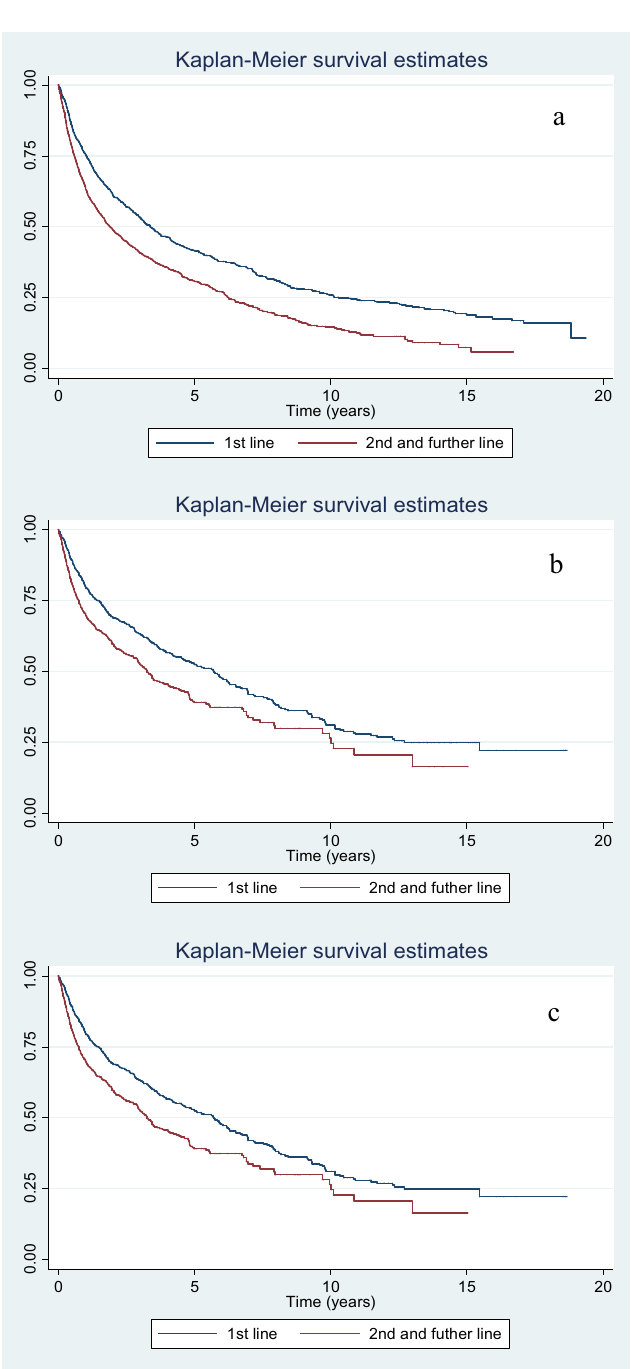
Figure 2. Kaplan–Meier survival curves for first-line treatment compared with second-line and successive treatments. ( a ) RA group (p < 0.001). ( b ) AS group (p < 0.001). ( c ) PsA group (p <